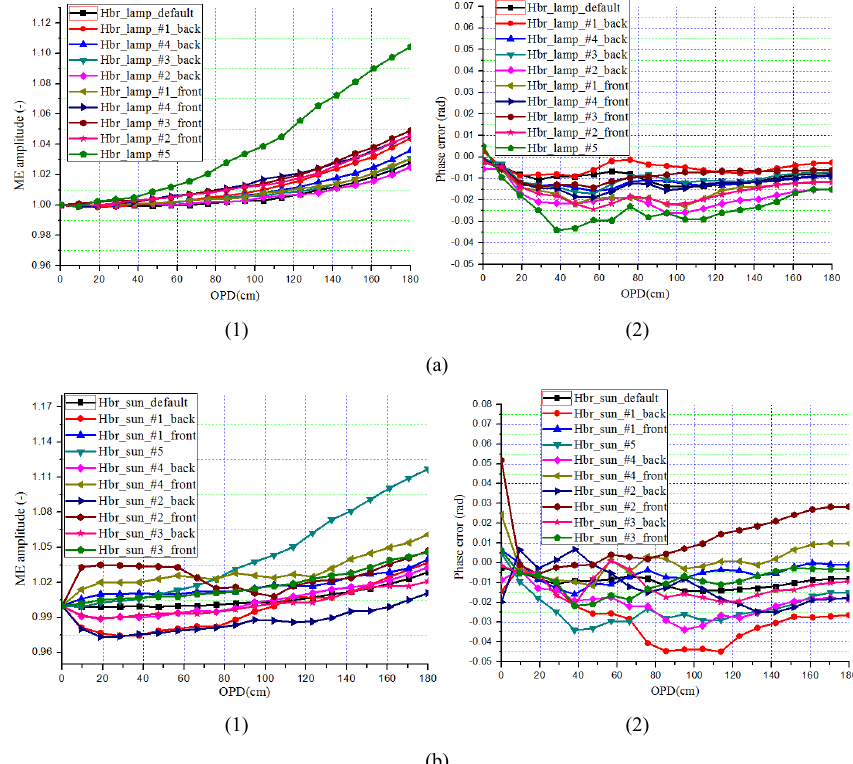
Figure 8. The same as Fig. 7 but for NDACC.